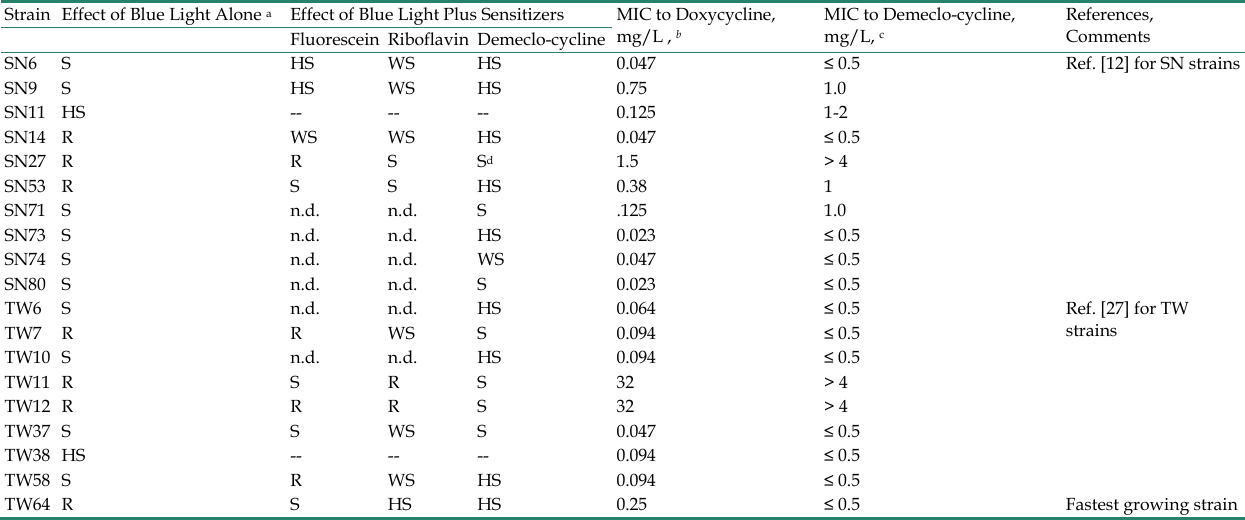
Table 1. Susceptibility of C. acnes Strains to Blue Light, Blue Light + Photosensitizers, and Tetracycline Antibiotics Strain Effect of Blue Light Alone a Effect of Blue Light Plus